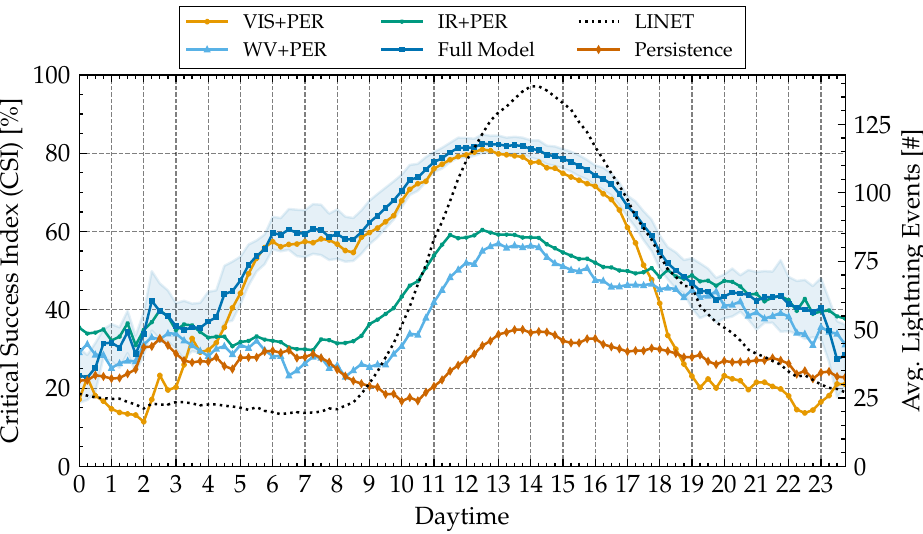
Figure 6. CSI over daytime (left y -axis): Performance measures for 120 min forecasts us- ing CSI for search radius 30.61 km of our method for the 2016/2017 test data sets, using only VIS+PER (VIS 0.6,VIS 0.8,nIR 1.6,Persistence), WV+PER (WV 6.2,WV 7.3,Persistence) and IR+PER (IR 3.9,IR 8.7,IR 9.7,IR 10.8,IR 12.0,IR 13.4,Persistence) channels. Average lightning events over daytime (right y